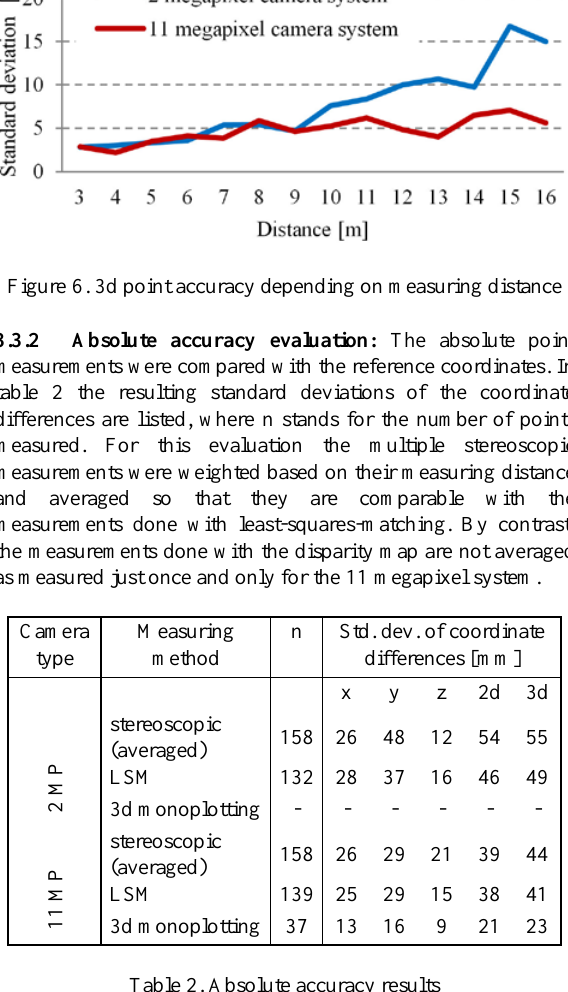
Table 2. Absolute accuracy results